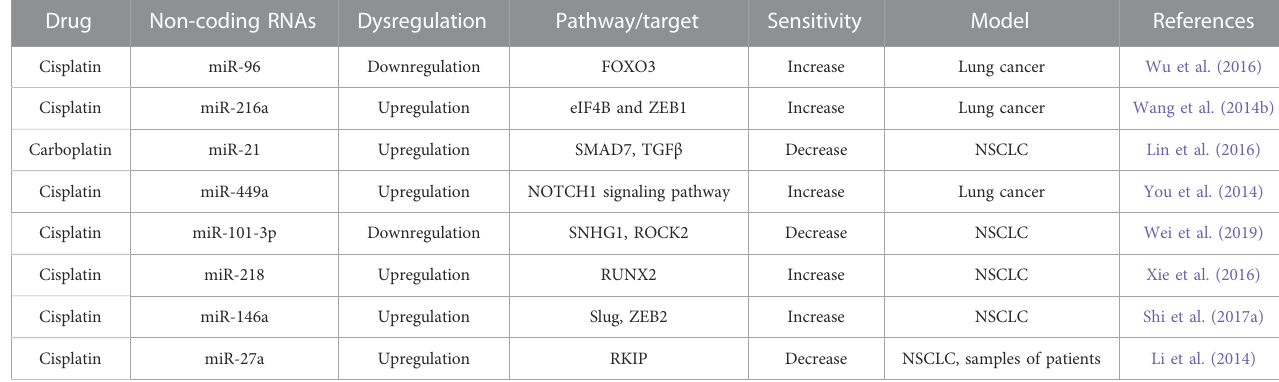
TABLE 5 Non-coding RNAs pro fi le dysregulation alter the potential targets involved in metastasis and